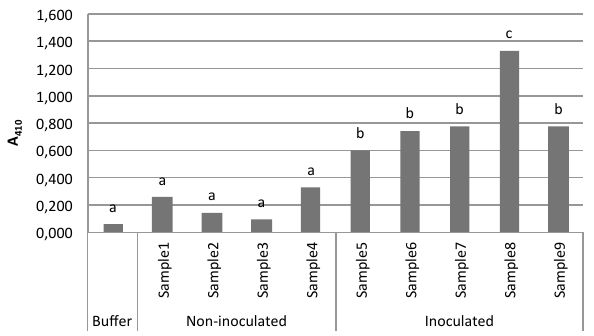
Figure 1. Mean absorbance values for TAS-ELISA detec- tion of Phaeomoniella chlamydospora colonizing grapevine wood, using the monoclonal antibody mAb116. . Samples 1-4, healthy grapevine wood material; samples 5‒9, inocu - lated grapevine wood material. Bars followed by different letters are significantly different ( P =0.05) according to the Tukey´s